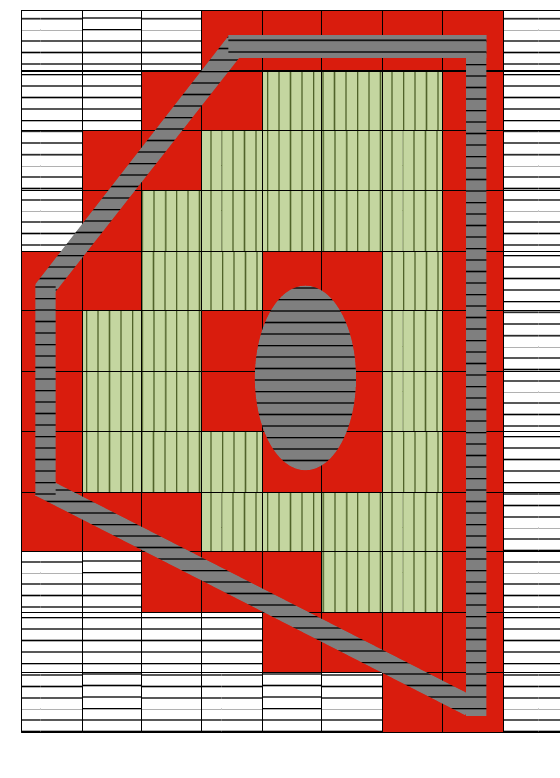
Figure 1. Occupancy Grid definition. ( a ) Unstructured environment to be mapped; ( b ) result of the